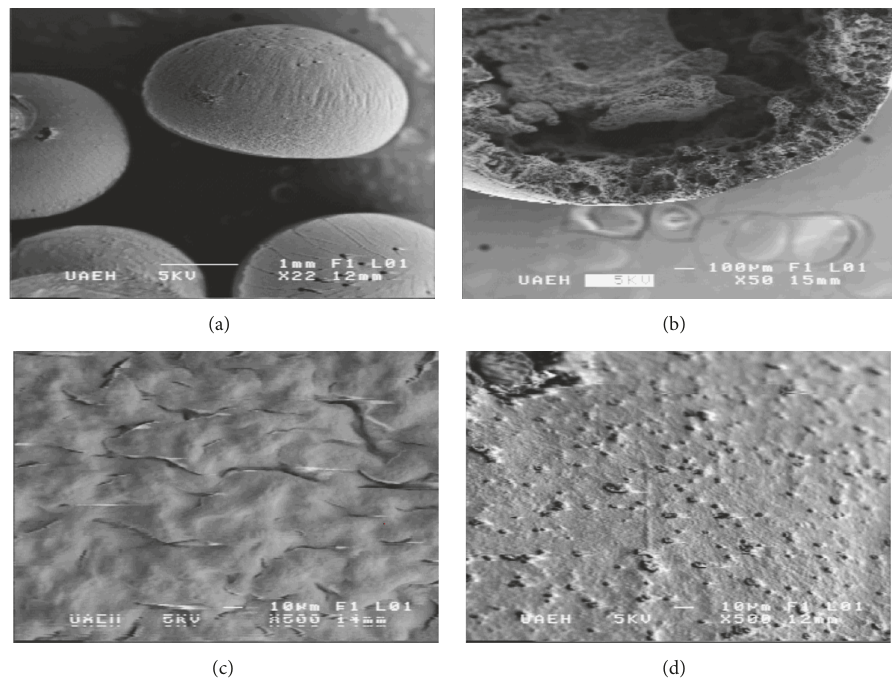
Figure 1: Scanning electron micrograph for (a) cellulose acetate microcapsules with Cyanex 923 at 1 molL −1 (22x); (b) cross section of CA- MC-Cy (50x); (c) cellulose acetate capsules surface (500x); (d) surface of CA-MC-Cy (22x).